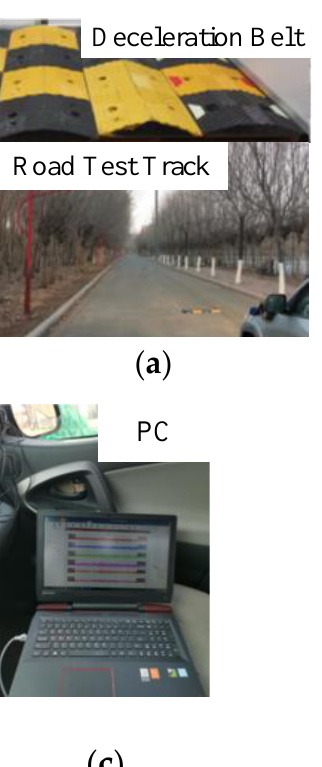
( b ) Figure 7. Diagram of speed reduction belt. ( a ) triangular speed reduction belt; ( b ) trapezoidal speed reduction belt. The experimental car passed over the speed bump at a constant speed of 20 km/h, and the same working condition, speed, and speed bump were set in CarSim. Figure 8 shows the acceleration responses of vertical body vibration and body roll angle when the vehicle passes over the triangular speed bump. ( a ) ( b ) Figure 8. Response of the body when passing over a triangular speed bump. ( a ) vertical acceleration of the body; ( b ) lateral camber acceleration of the body. From Figure 8, it can be seen that the trends of the real vehicle and the CarSim model are the same in the body droop acceleration and body side camber acceleration. The front wheels and rear wheels passing over the speed bump in turn cause the two sudden signal 0